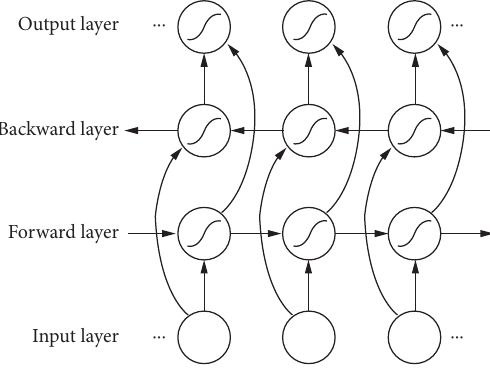
Figure 5: The structure of